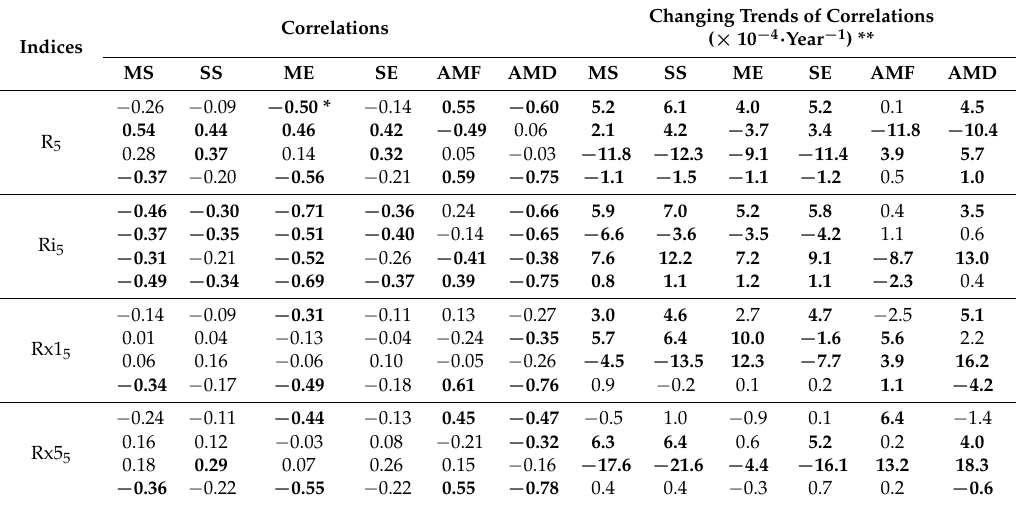
Table 6. Correlation between the precipitation extremes and the topographic and circulation factors and the corresponding